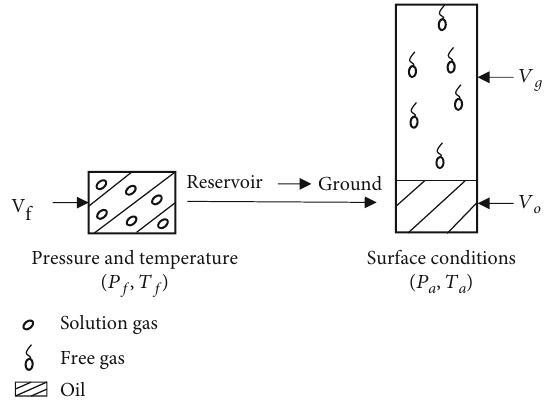
Figure 1: Flash separation schematic